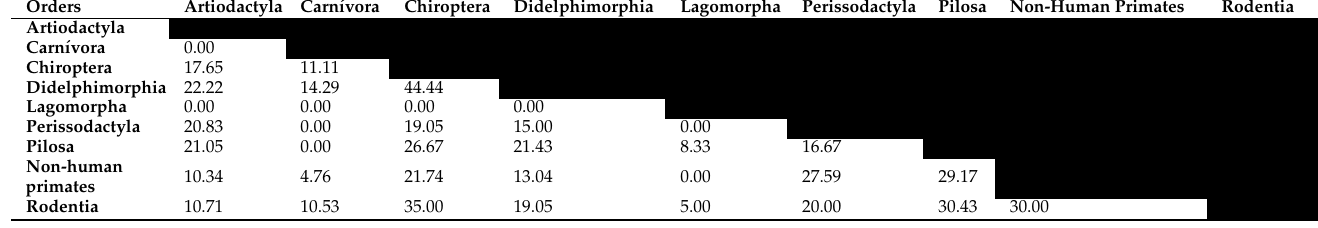
Table 5. Similarity index according to Jaccard’s index among mammal orders in the Neotropics.